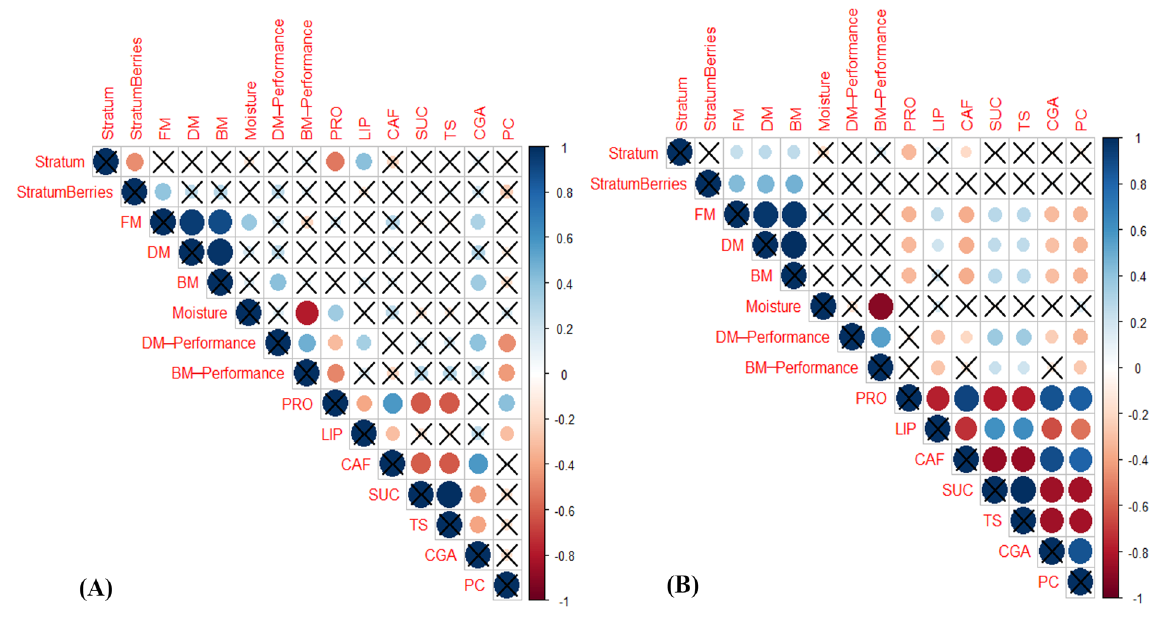
Figure 6. Graphical presentation of coefficients (values corresponding to circle size and color intensities) and p ‐ values < 0.05 (not crossed circles) for general correlations among berry distribution along plant canopy strata (Stratum (S1–S4), StratumBerries (number of berries stratum − 1 )), yield [FM and DM (fresh and dry berry mass stratum − 1 respectively), BM (processed bean mass stratum − 1 ), initial berry moisture, DM and BM performances, and chemical parameters (PRO (proteins), LIP (lipids), CAF (caffeine), SUC (sucrose), TS (total soluble sugars), CGA (total chlorogenic acids), PC (phenolic compounds)) of four Coffea arabica genotypes in ( A ) 2012, and ( B ) 2013.